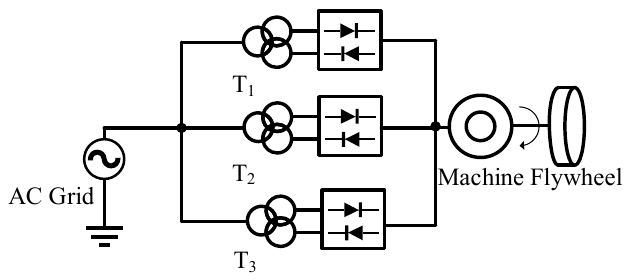
U out Figure 21. The Quasi-Z source converter topology with supercapacitor. 3.4. Structure of the Energy Storage System with Flywheel The flywheel energy storage requires external acceleration to transfer kinetic energy.